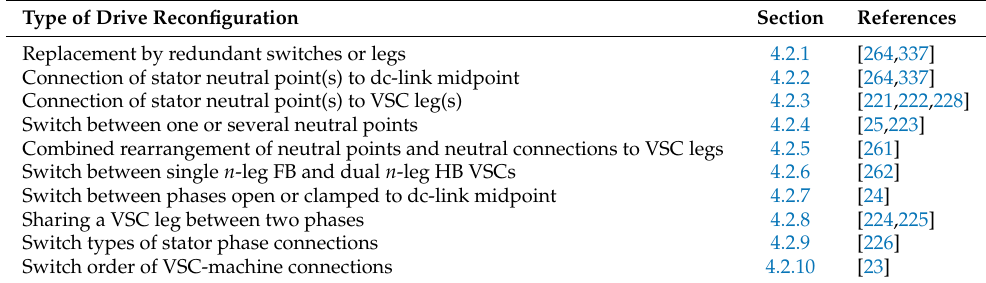
Table 20. Classification of references (and paper sections) about tolerance to phase/switch OCs according to the type of drive reconfiguration (Section 4.2) in multiphase applications in the literature. Type of Drive